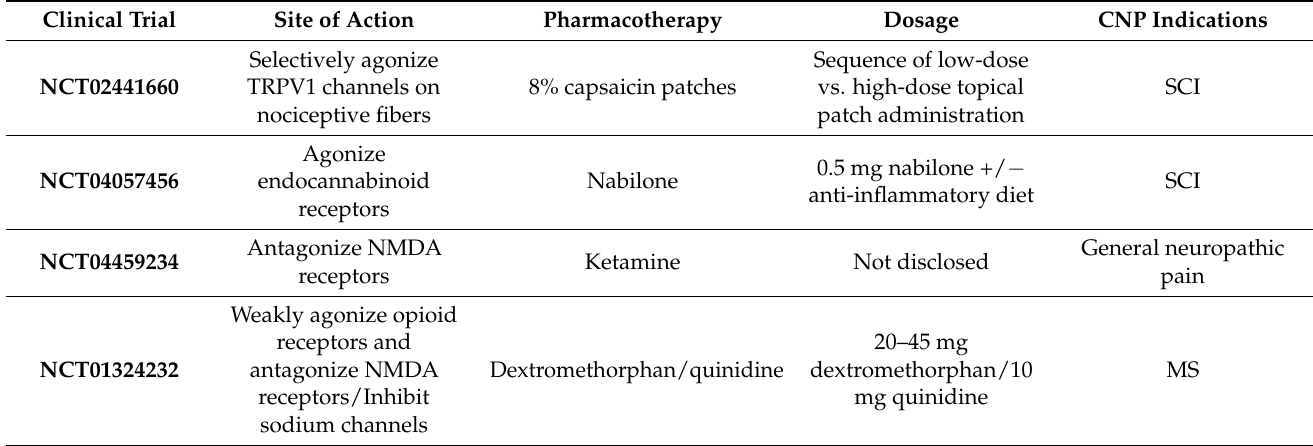
Table 2. Ongoing Clinical Trials in CNP. Summary regarding ongoing variations in pharmacotherapy being assessed for the treatment of central pain